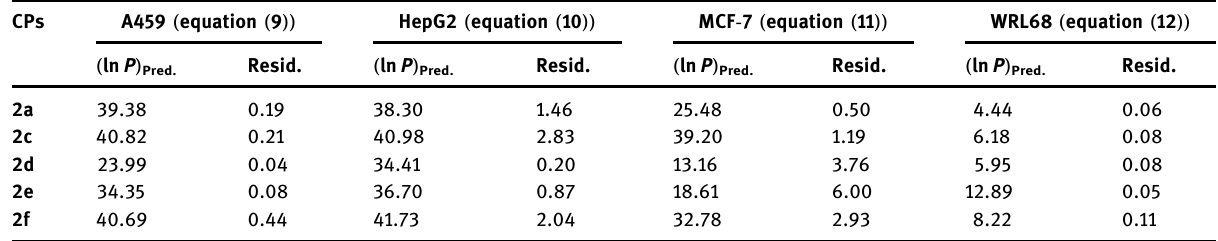
Table 10: Predicted percentage inhibition and residuals obtained by using MLR equations ( 9 ) – ( 12 ) and considering compounds